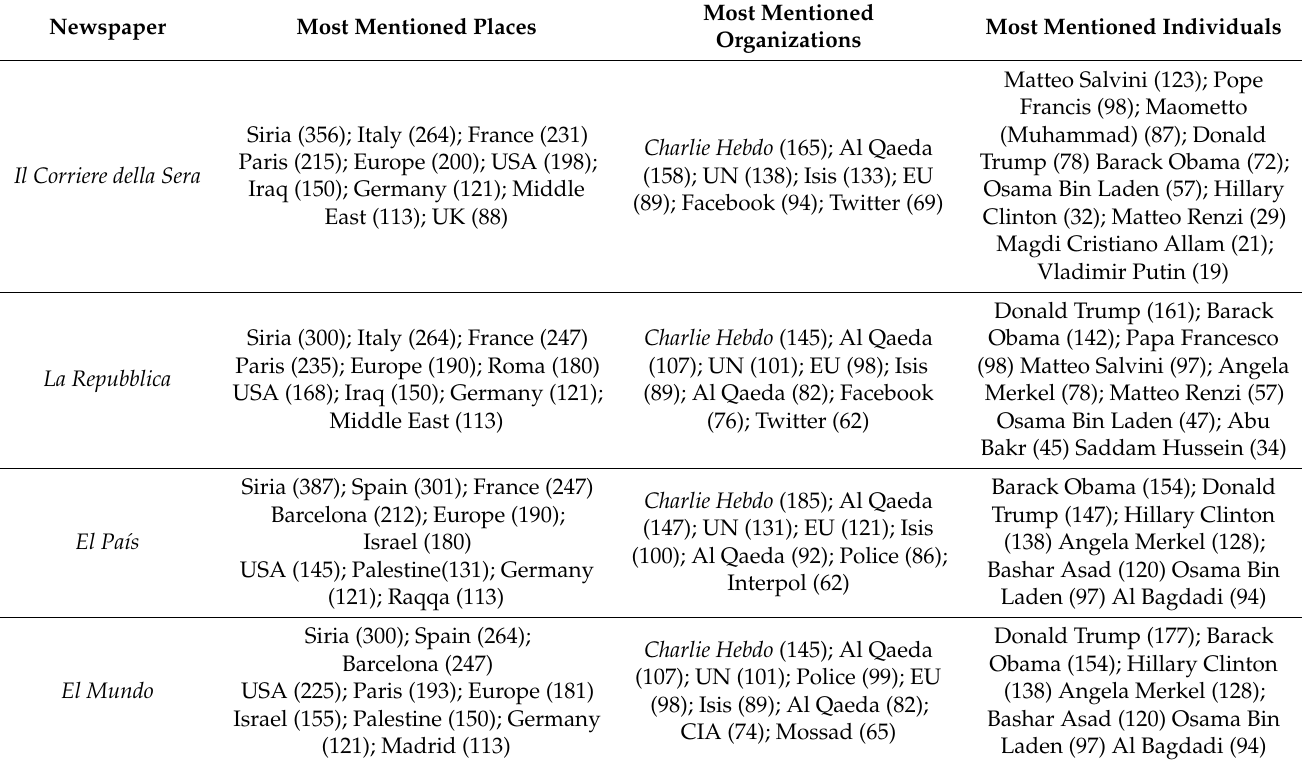
Table 1. Words distribution.